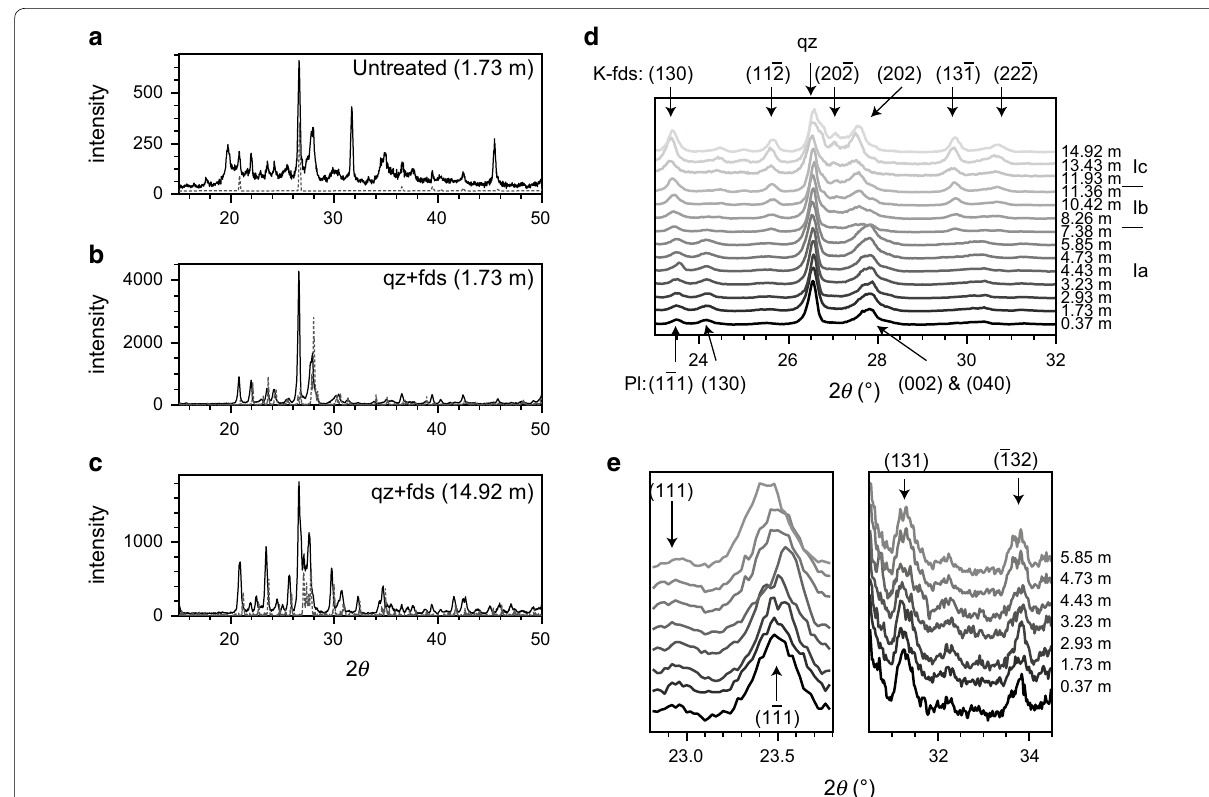
Fig. 3 Results of XRD analyses. a – c Representative diffractograms of untreated sample from 1.73 m ( a ), quartz and feldspars from 1.73 m ( b ), and quartz and feldspars from 14.92 m ( c ). Dashed lines represent reference diffraction patterns for quartz ( a ; RRUFFID RRUFFID R040068), and sanidine ( c ; RUFFID R060313) in arbitrary scale. Data are downloaded from RRUFF project (http://rruff .info/). d Depth = = variation of the diffractograms for quartz and feldspars showing changing contribution of potassium feldspar and plagioclase. Each diffractograms are normalized by the peak of quartz (qz). Some peak identifications were given for potassium feldspar (K-fds) and plagioclase (pl) on the top and bottom of the plot, respectively. e Blowup of diffractograms for plagioclase composition determination using the separations between ( 111 ) and ( 1 ¯ 11 ) (left), and ( ¯ 132 ) and ( 131 )